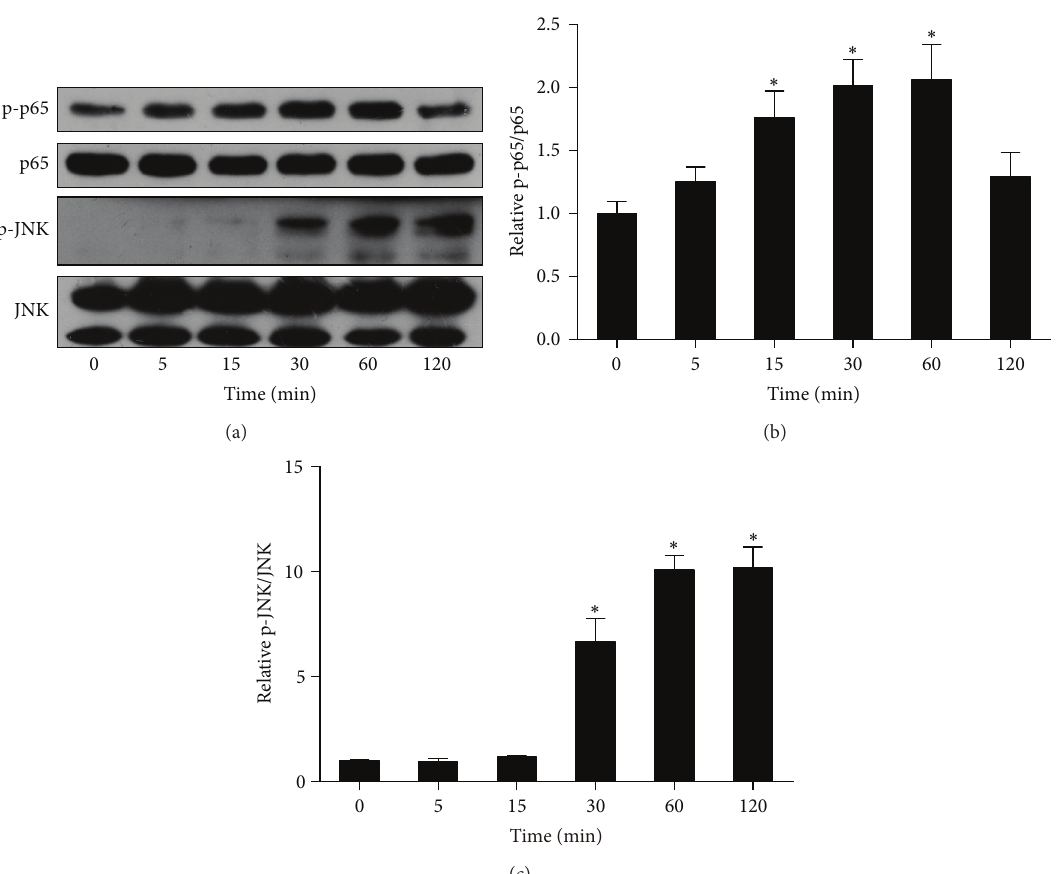
Figure 7: FSTL1 activates proinflammatory signaling pathways in RAW264.7 macrophages. RAW264.7 macrophages were treated with recombinant mouse FSTL1 (100ng/mL) for indicated time periods (0–2 h). (a) Expression and phosphorylation of NF 𝜅 B and JNK were assessed by Western blot analysis. (b) and (c) Intensity of bands was quantified by densitometry and expressed as ratio of phosphorylated to total protein. The ratio was normalized to control. Data are mean ± SE; 𝑛 = 3 . ∗ 𝑃 < 0.05 versus control